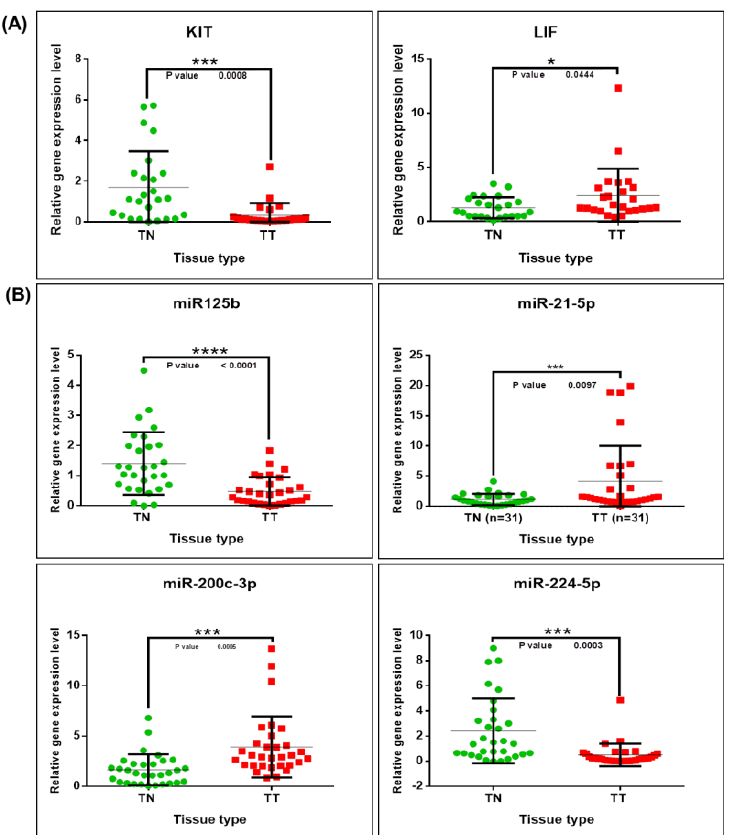
Figure 6. Gene and miRNA expression alterations in breast cancer. ( A ) Scatter plots demonstrating the downregulation of KIT and upregulation of LIF in tumor tissues versus normal tissues. ( B ) Scatter plots showing the downregulation of miR-125b and miR-224-5p, as well as the upregulation of miR-21-5p and miR-200c-3p in tumor tissues versus normal tissues. For normalization of the gene expression data, B2M and GAPDH were used as the internal controls, whereas, for miRNA data, U6 and RNU48 were used as the internal controls, based on the ΔΔCt method (* p ≤ 0.05, *** p ≤ 0.001, **** p ≤ 0.0001).